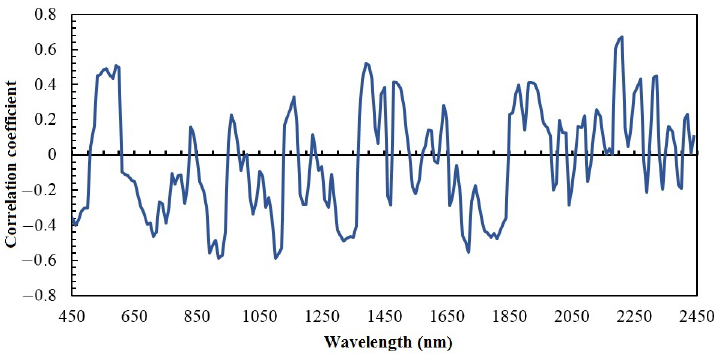
Figure 6. Correlation between the samples’ FD absorbance spectra and Cr concentration.